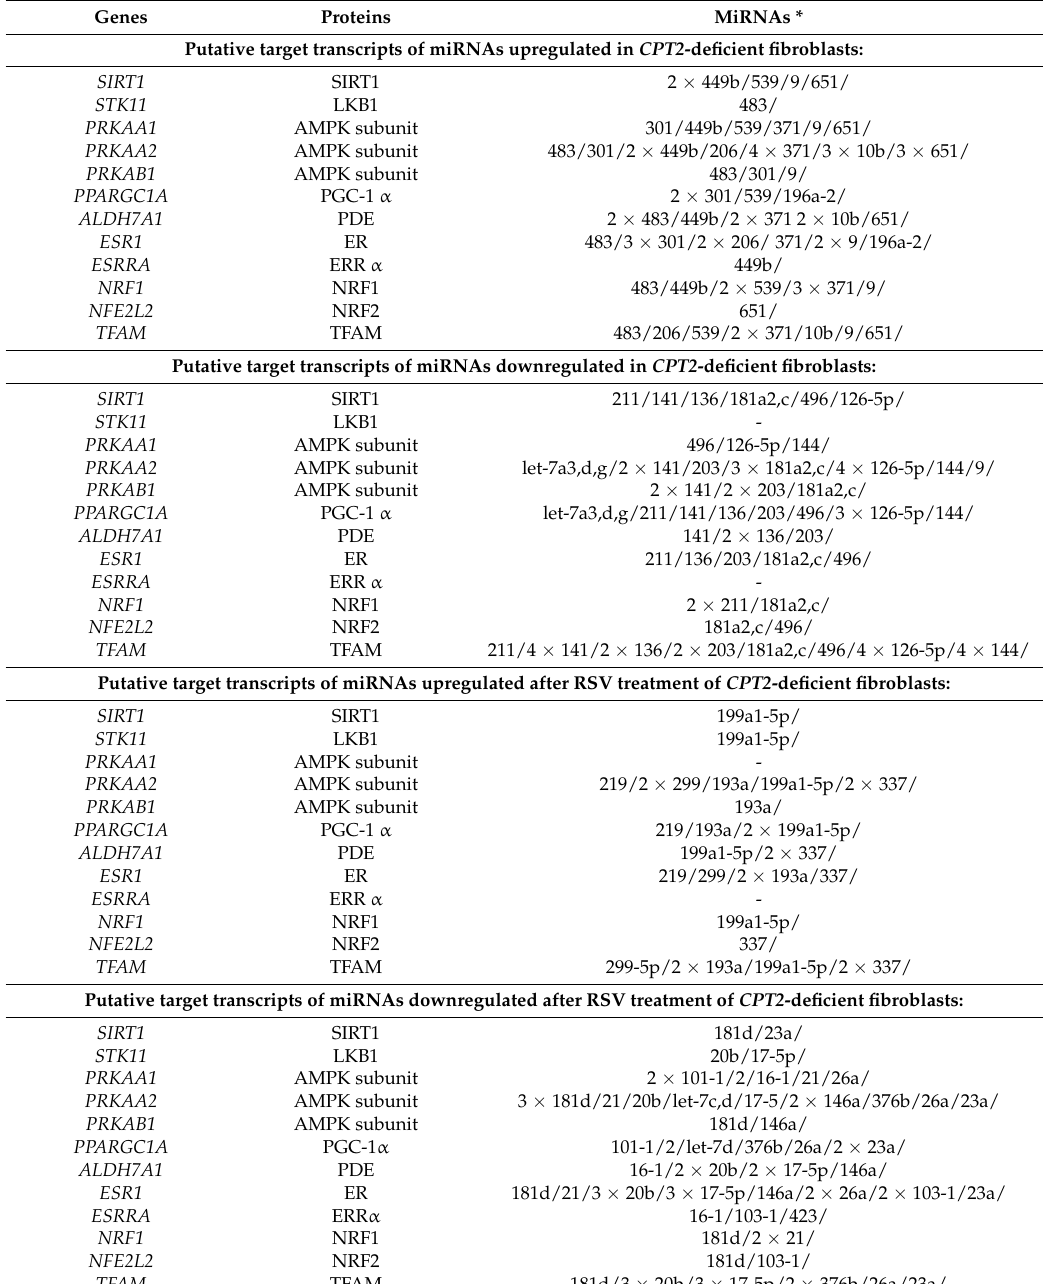
Table 3. Putative targets transcripts of miRNAs of Tables 1 and